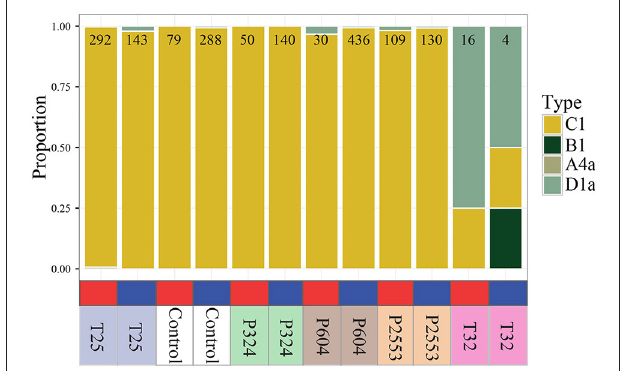
FIGURE 2 | Proportion of RNAseq reads mapping exclusively to one Symbiodinium lineage (A4a, B1, C1, D1a) for each transcriptome library, with independent columns representing a unique transcriptome library. Number at top of bar indicates total number of reads mapping exclusively to one clade within that library. Red and blue blocks indicate that the library originated from nearshore and forereef corals, respectively. Treatment conditions are noted below the bar (T25 = 25.01 ± 0.14 ◦ C, 515 ± 92 µ atm; Control = 28.16 ± 0.24 ◦ C, 477 ± 83 µ atm; P324 = 28.14 ± 0.27 ◦ C, 324 ± 89 µ atm; P604 = 28.04 ± 0.28 ◦ C, 604 ± 107 µ atm; P2553 = 27.93 ± 0.19 ◦ C, 2553 ± 506 µ atm; T32 = 32.01 ± 0.17 ◦ C, 472 ± 86 µ atm). All libraries were dominated by Symbiodinium goreaui (C1), excepting the T32 treatments that were dominated by Symbiodinium trenchii